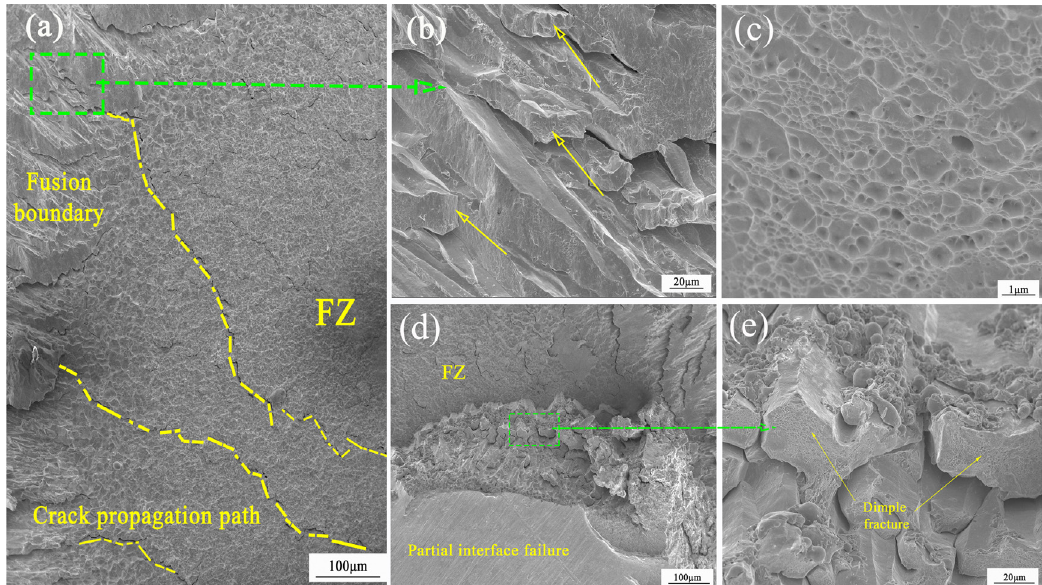
Figure 7. Fracture morphology of partial interface failure: (a) crack propagation path; (b) edge fracture in the fusion zone; (c) dimples in the arrow direction in Figure b; (d) macroscopic fracture; (e) amplification morphology of frame-line